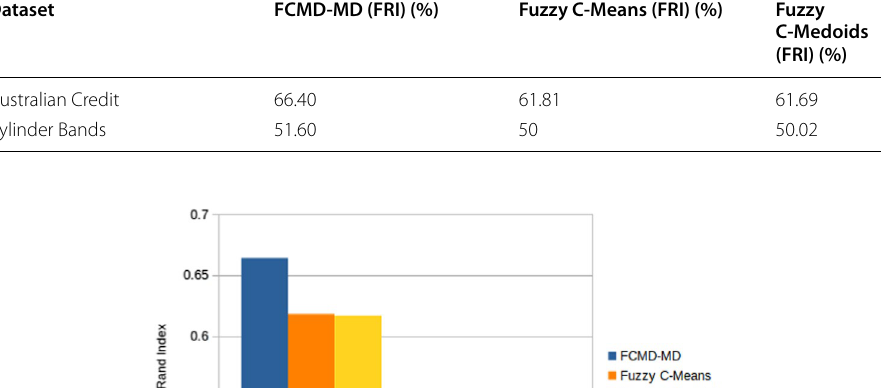
Table 4 Average Fuzzy Rand Index achieved by FCMD-MD, Fuzzy C-Means and Fuzzy C-Medoids Dataset